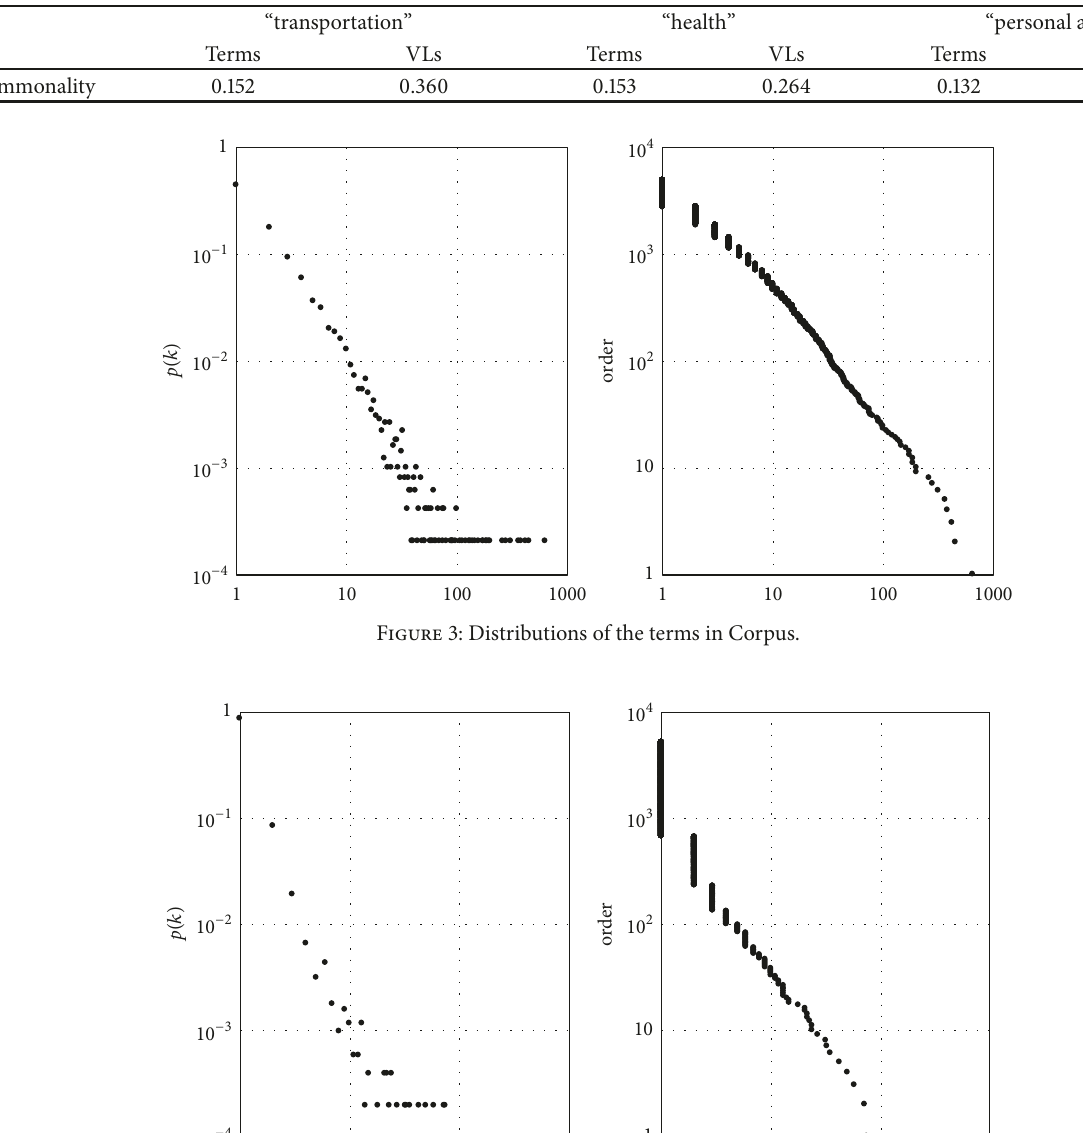
Table 5: Commonalities of terms and VLs of three themes.